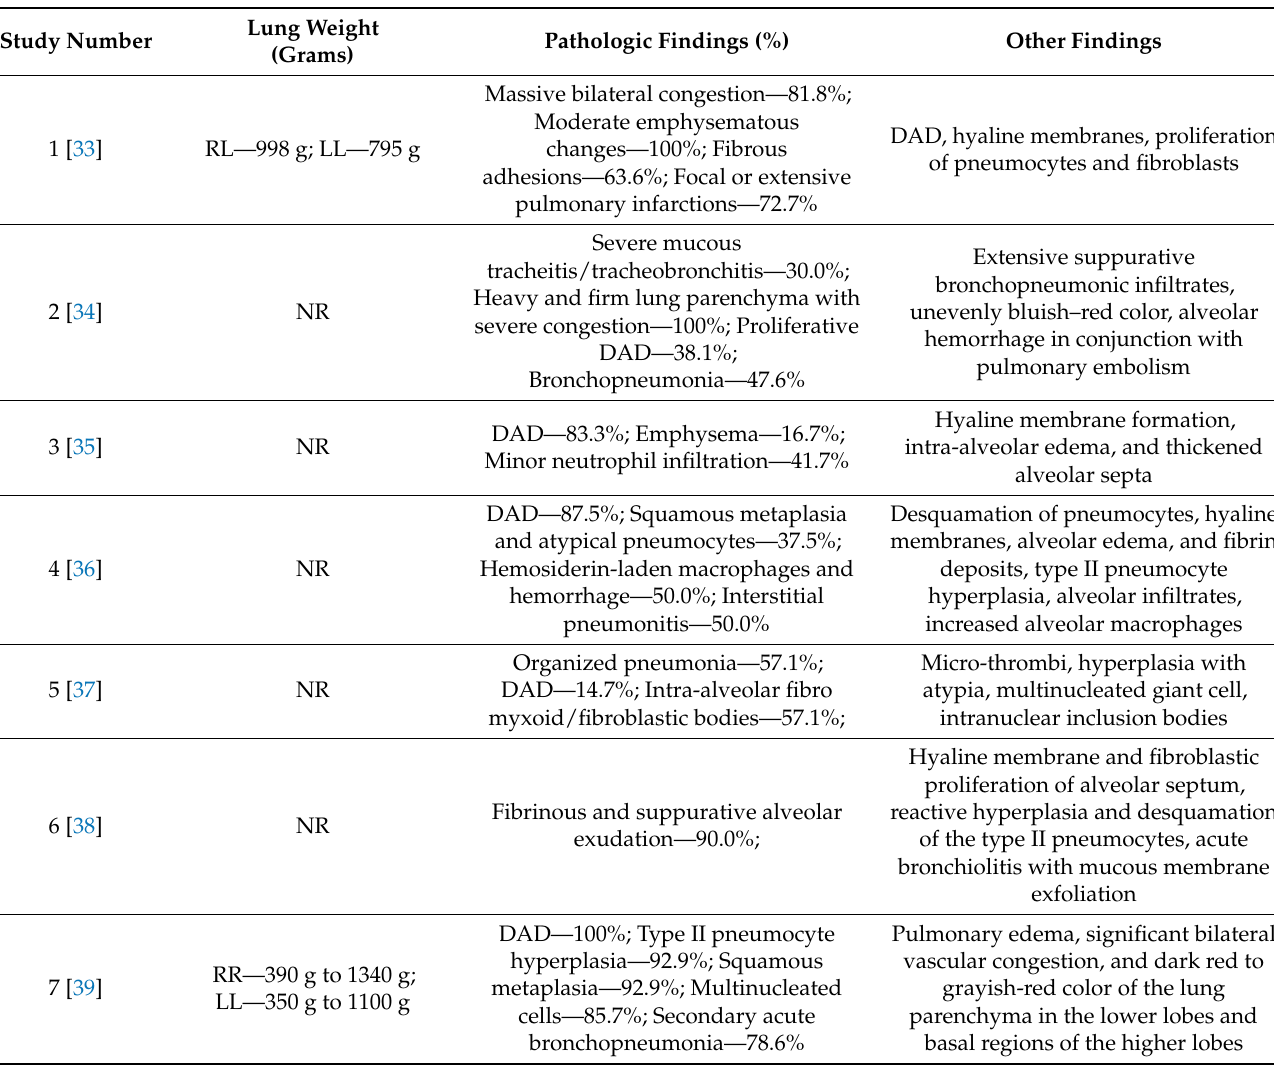
Table 3. Pathology findings of the lungs in the included